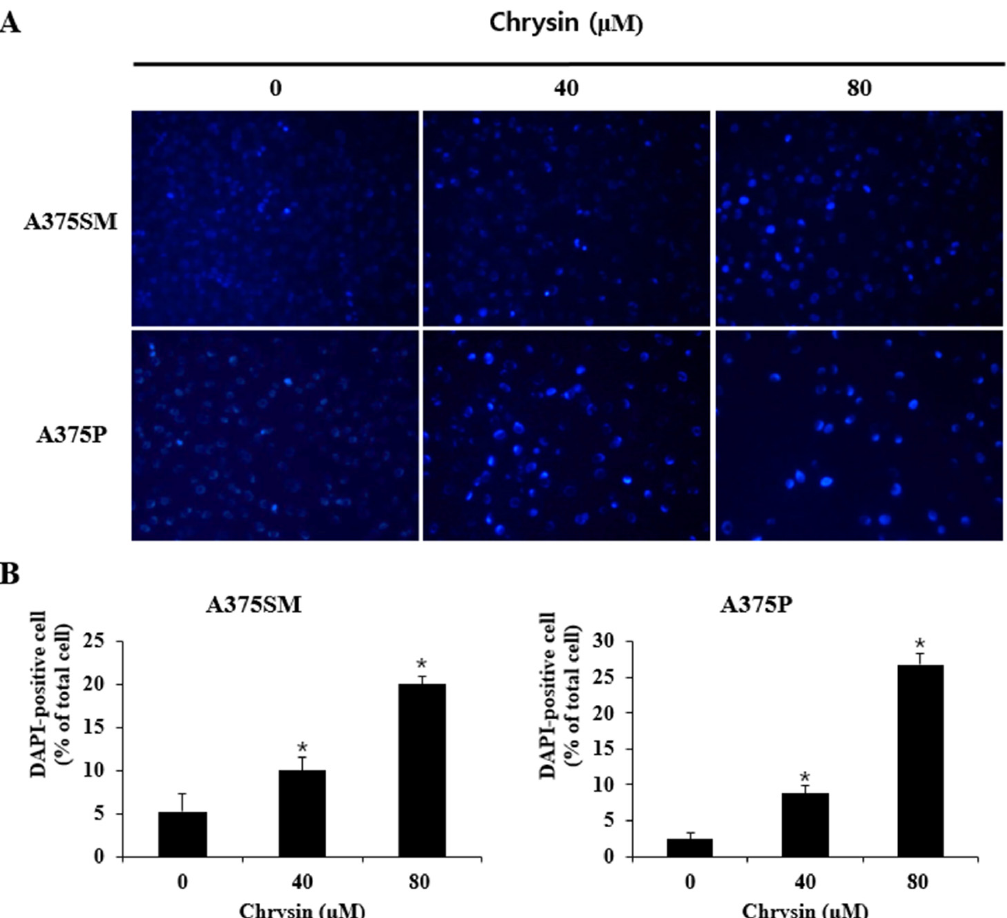
Figure 2. Chrysin induces apoptotic body formation in A375SM and A375P human melanoma cancer cells. ( A ) Cells were seeded for 24 h and then incubated with the indicated concentration of chrysin for 24 h. After that, cells were fixed and stained with DAPI solution. Cell morphological changes were analyzed using a fluorescence microscope (200×). ( B ) The bar graph represents the average of four fields under a fluorescence microscope and the percentage of DAPI-positive cells among all cells. Data are presented as the mean and standard deviation for three samples. Significance was determined by Student’s t -test, * p < 0.05, compared with the control.